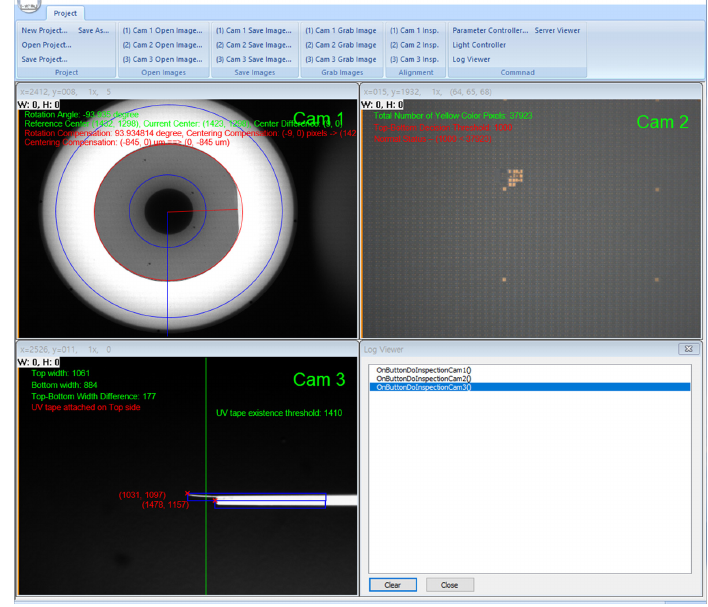
Figure 11. GUI software of vision aligner.